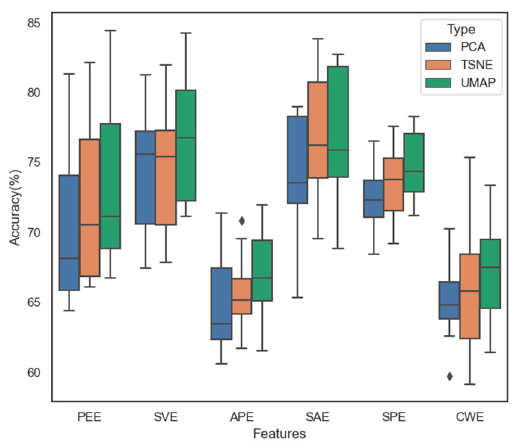
Figure 14. Comparison of classification accuracy of PCA, t-SNE, and UMAP with SVM using all features across eight subjects.